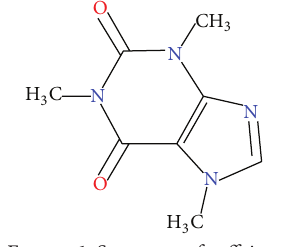
Figure 1: Structure of caffeine.